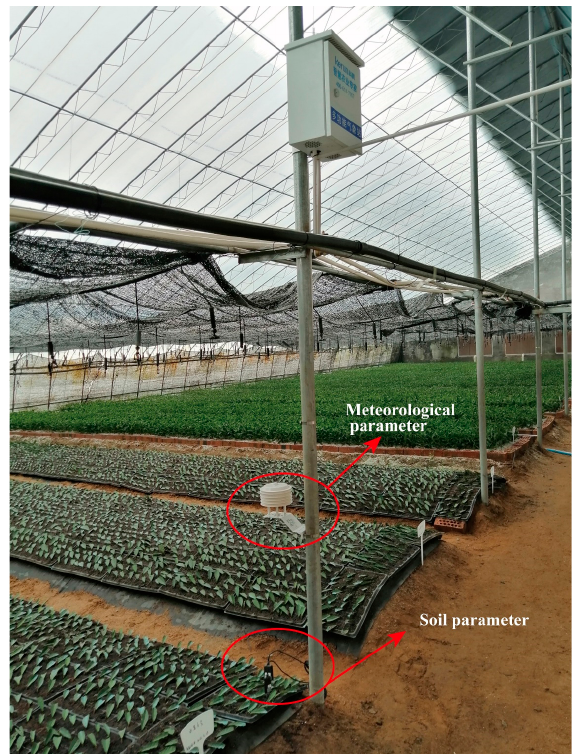
Figure 1. Climate collection system in seedling greenhouse. 2.4. Establishment of CNN-LSTM Model The CNN-LSTM consisted of two parts, the CNN spatial feature extraction module